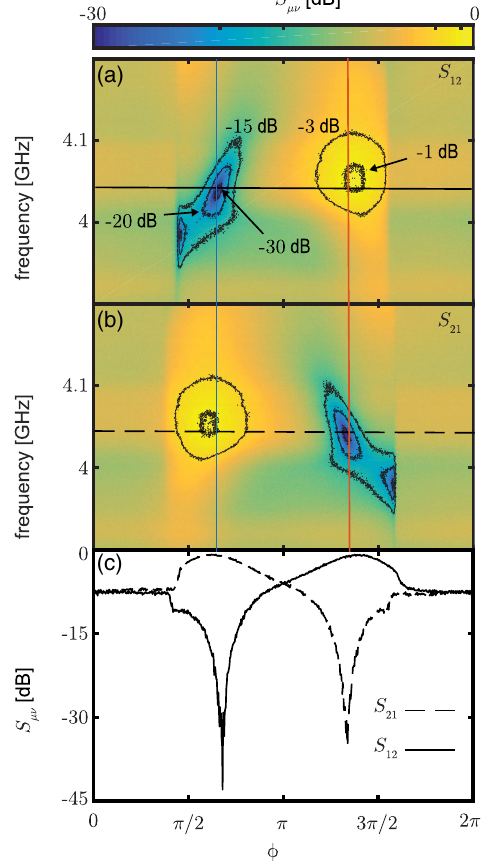
FIG. 9. Measurements of a dynamically reconfigurable circu- lator. The phase ϕ between the gradiometric flux lines determines the direction of circulation. Counterclockwise (a) and clockwise (b) transmission as a function of the probe frequency and the phase ϕ . Vertical and horizontal lines indicate the location of line cuts plotted in (c) and Fig. 6(a). (c) Counterclockwise (dashed line) and clockwise (solid line) transmission at probe frequency ω ¼ 2 π × 4 . 044 p